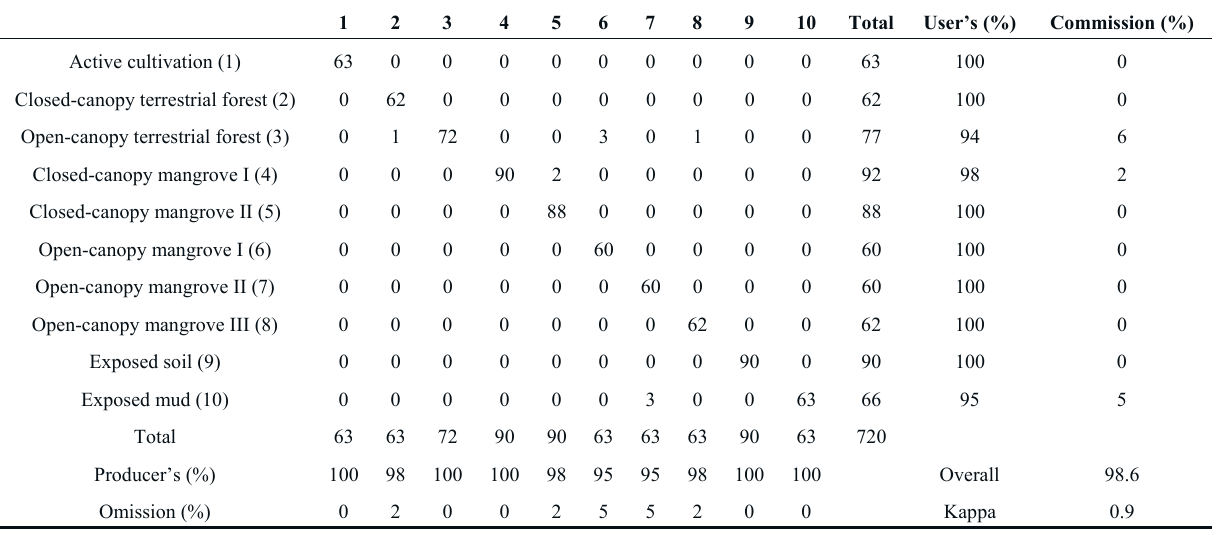
Figure 5. The mean spectral value (±1 standard deviation) of mapped categories. Table 3. Results of accuracy assessment for classification of Landsat